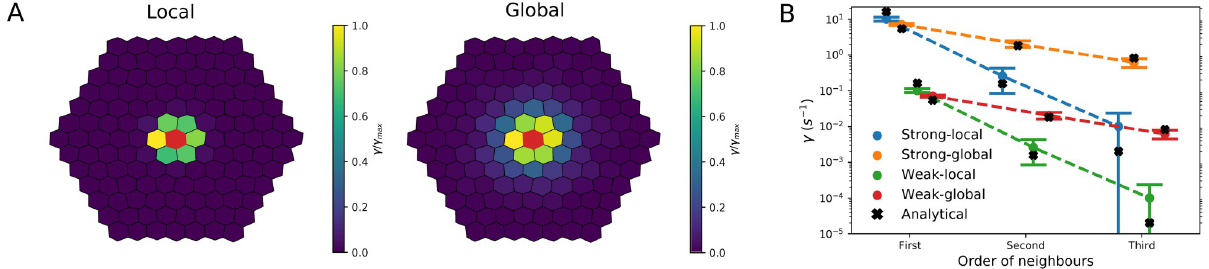
Fig 4. Communication regimes in the ISD model. A: We generated a configuration of 127 cells with mean polygon number 6. Here cells are coloured according to the values of their exchange rate γ with the central cell (coloured in red), normalized to the maximum γ max . This is shown in the local ( D = 10 μm 2 / s , left panel) and global ( D = 1000 μm 2 / s , right panel) communication regime. B: Mean and standard deviation of the exchange rates with the central cell of the configuration shown in panel A (y axis), for the n-th neighbours (x axis). Circles represent values obtained from the simulations, while the crosses are the analytical estimations. Four different combinations of parameters are used, corresponding to strong/weak and global/local communication regimes. Parameter values: α = 1.0 s − 1 and α = 100.0 s − 1 for weak and strong communication; D = 10 μm 2 / s and D = 1000 μm 2 / s for local and global communication,